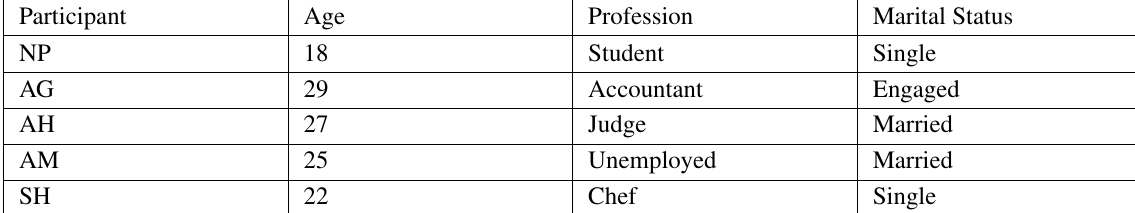
Table 2. Gated Residential Area